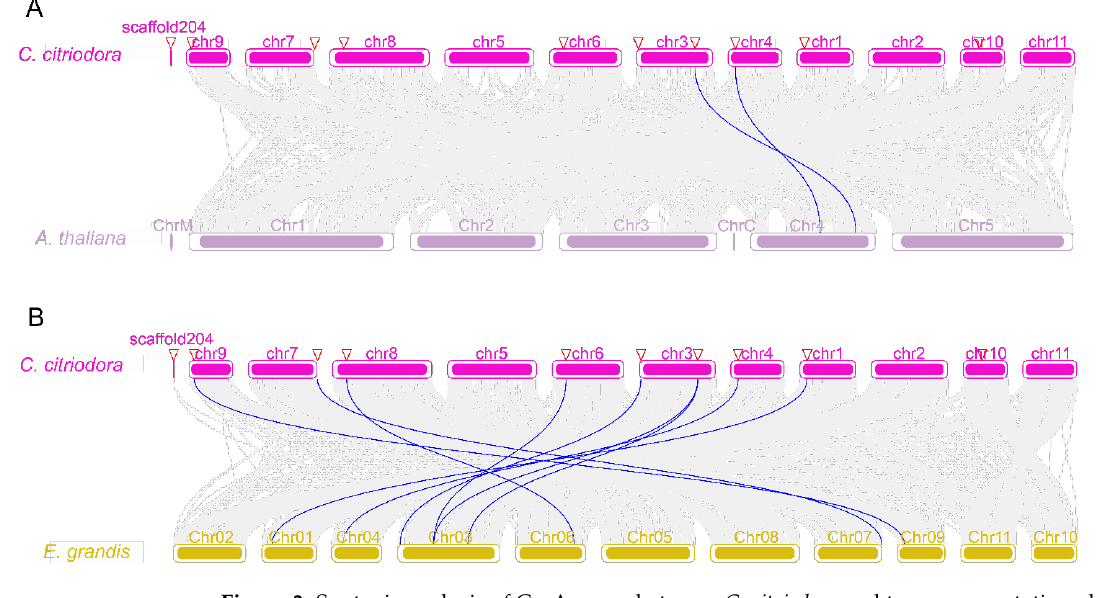
Figure 3. Syntenic analysis of CesA genes between C. citriodora and two representative plant species. ( A ) Syntenic relationship between C. citriodora and Arabidopsis thaliana . ( B ) Syntenic relationship between C. citriodora and Eucalyptus grandis . Gray lines at the bottom indicate the collinear blocks within the C. citriodora and other plant genomes. The blue lines indicate the pairs of CesA genes.